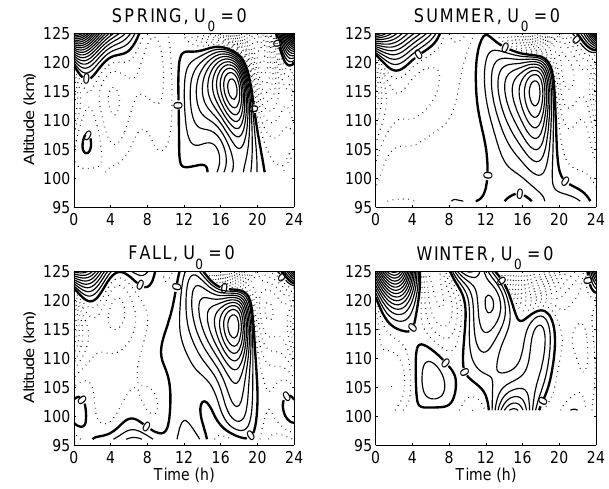
Fig. 6. Vertical velocity field when the background wind is removed for each of the four seasons; the same plot details as in the previous